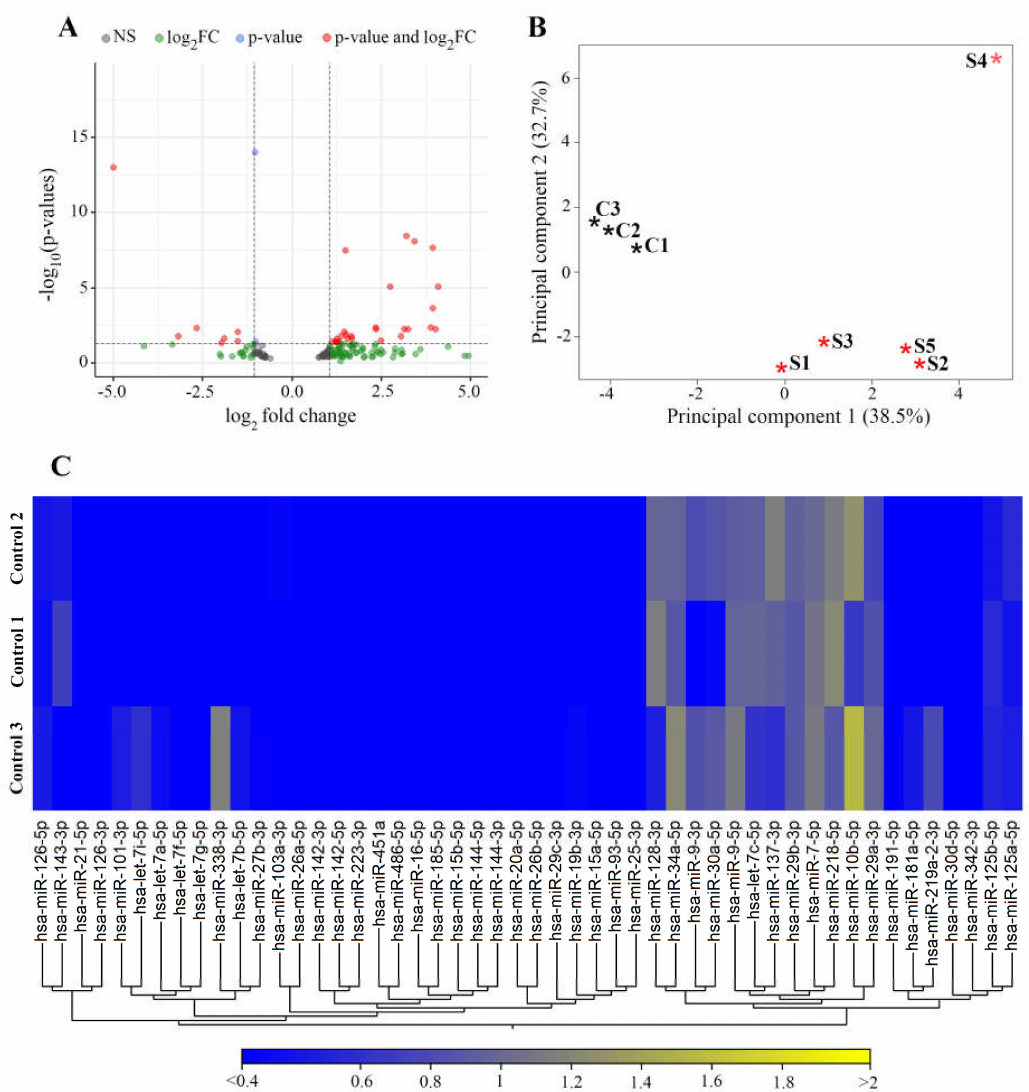
Figure 4. Visualization of miRNA expression in stroke and control tissue. ( A ): Volcano plot showing the magnitude of the difference in expression values of the samples in Control and Stroke groups. The graph is constructed by plotting the − log 10 (FDR corrected p -value) on the y-axis, and the log 2 (fold-change) on the x-axis from the group of 172 miRNAs with impaired expression in stroke patient vs. control samples. Grey circles represent samples with FDR p -value > 0.05, green circles represent miRNAs that have a fold-change > 1.5 and FDR p -value > 0.05, blue circles represent miRNAs that have an FRD p -value < 0.05 and a fold-change > 1.5, and red circles represent miRNAs that have an FDR p -value < 0.05 and fold-change >2.0. ( B ): Principal component analysis (PCA) plot for stroke and control samples. The PCA was performed on 34 miRNAs identified to be differentially expressed between stroke and non-stroke control samples using the miRNAs that have the largest coefficient of variation based on TMM normalized counts. Each asterisk represents a sample. Red asterisk–stroke samples from patients S1–S5; black–control non-stroke samples C1–C3. ( C ): A heat map demonstrating expression levels of 50 microRNAs in three different control samples. Each column represents one miRNA and each row represents one sample. The color represents the difference of the count value to the row mean. N = 5 stroke and 3 control